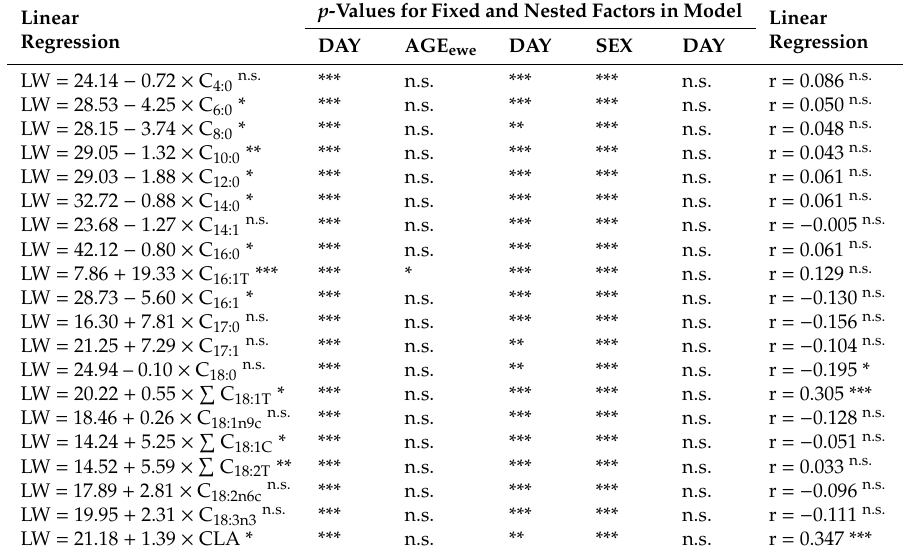
Table 2. Regression–correlation analysis s between lambs live weight and selected fatty acids in fat of Wallachian sheep milk. p -Values for Fixed and Nested Factors in Model Linear Linear Regression RegressionDAY AGE